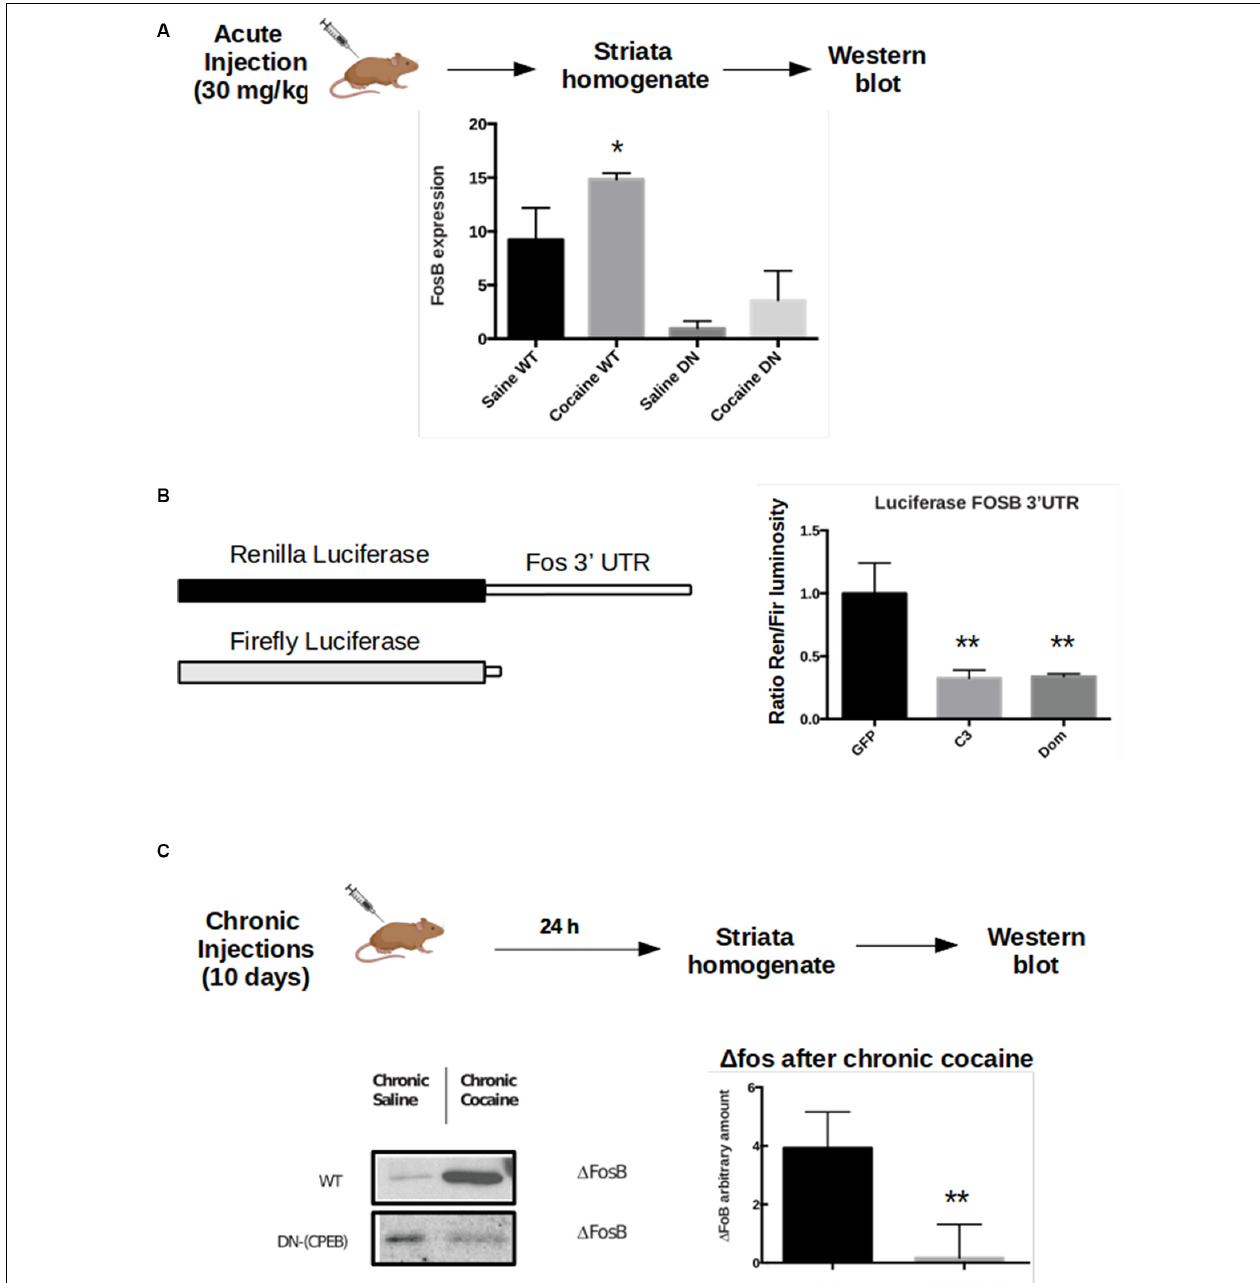
FIGURE 6 | FosB is a CPEB3 target whose expression in the striatum is misregulated following cocaine injections. WT and DN-CPEB mice ( n = 5) treated with acute cocaine. (A) FosB expression increases in WT but not in the DN-CPEB suggesting that FosB could be a direct target of CPEB 1 and 3. (B) Dual-Luciferase assay on HEK cells co-transfected with FosB 3 (cid:48) UTR Renilla plasmid and Firefly luciferase, in the presence of CPEB3 or DN-CPEB. The presence of CPEBs induces significantly less translation of the Renilla Luciferase gene, a shown in the change of renilla/Firefly ratio. (C) ∆ FosB, a spliced form of FosB, is highly expressed in the NAc after chronic cocaine i.p. injections. ∆ FosB expression increase following chronic cocaine injections in WT mice but not in DN-CPEB transgenic ( n = 5, p < 0.01, Student’s t -test). * p < 0.05, ** p <